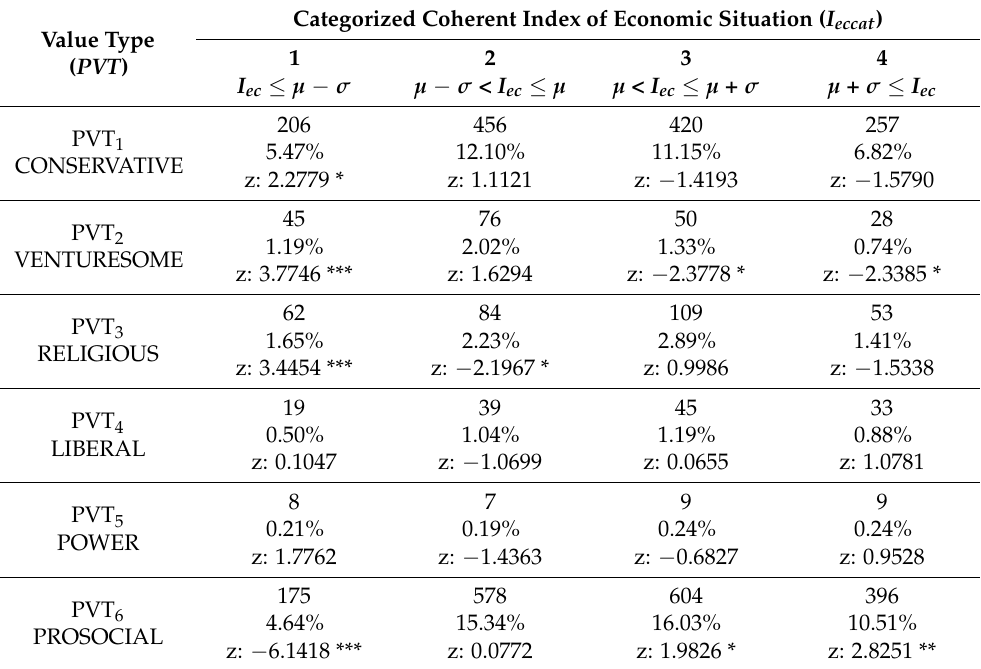
Table 7. I eccat / PVT contingency table and standardized residuals (z-score) for each condition. Value